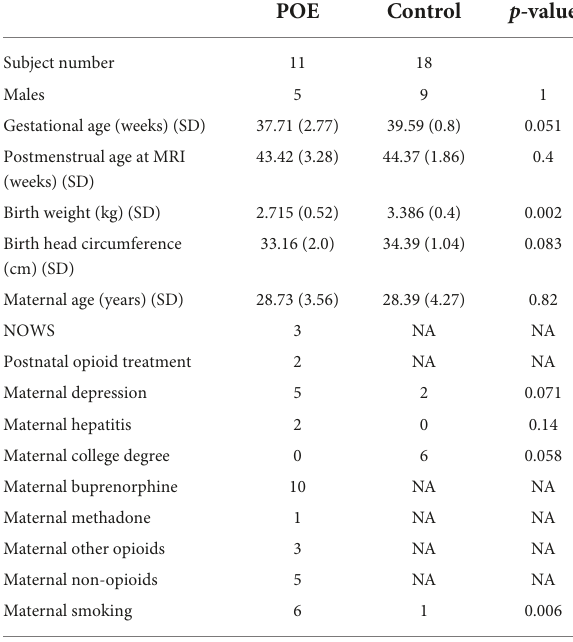
TABLE 1 Demographic information of